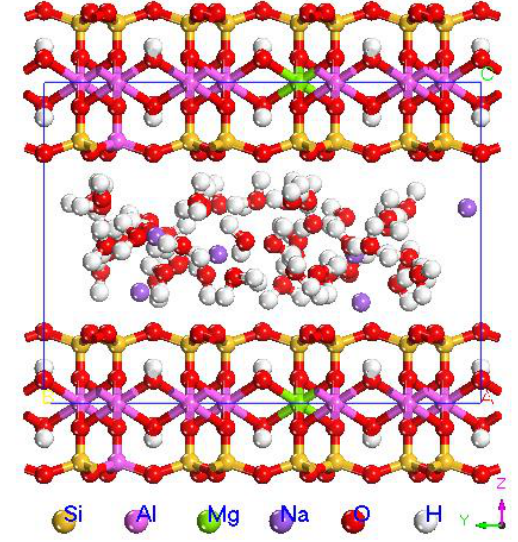
Figure 1. Super-cell model of Na-montmorillonite (Mg octahedral are green, Al octahedral and tetrahedral purple, Si tetrahedral brown, O atoms red, H atoms white, and Na ions cyan).